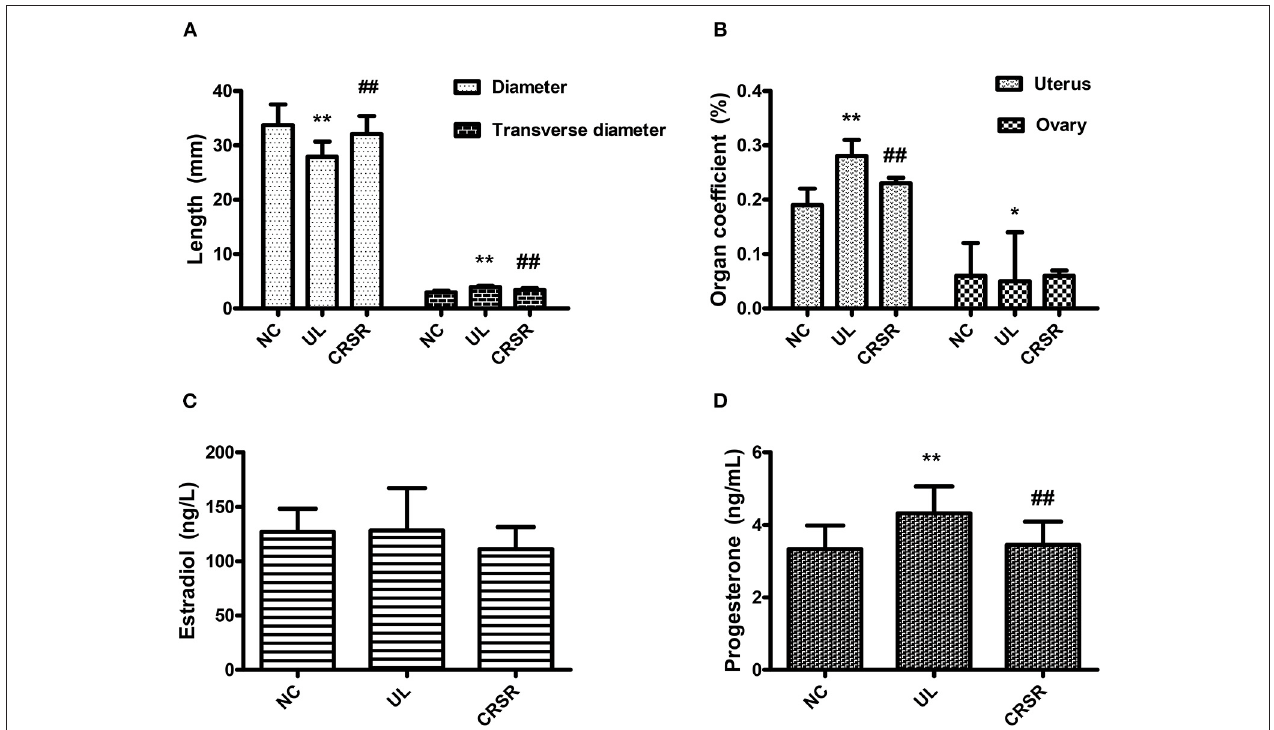
FIGURE 3 | (A) Effects of CRSR on the transverse diameter and diameter of the uterus. (B) Effects on the uterine and ovarian coefficients. (C,D) Changes of E 2 and P in the serum. Data are reported as mean ± SD. NC, normal control group; UL, uterine leiomyoma model group; CRSR, Curcumae Rhizoma and Sparganii Rhizoma treatment group; E 2 , estradiol; P, progesterone. * p < 0.05, ** p < 0.01 UL vs. NC; # p < 0.05, ## p < 0.01 CRSR vs. UL (one-way ANOVA and LSD